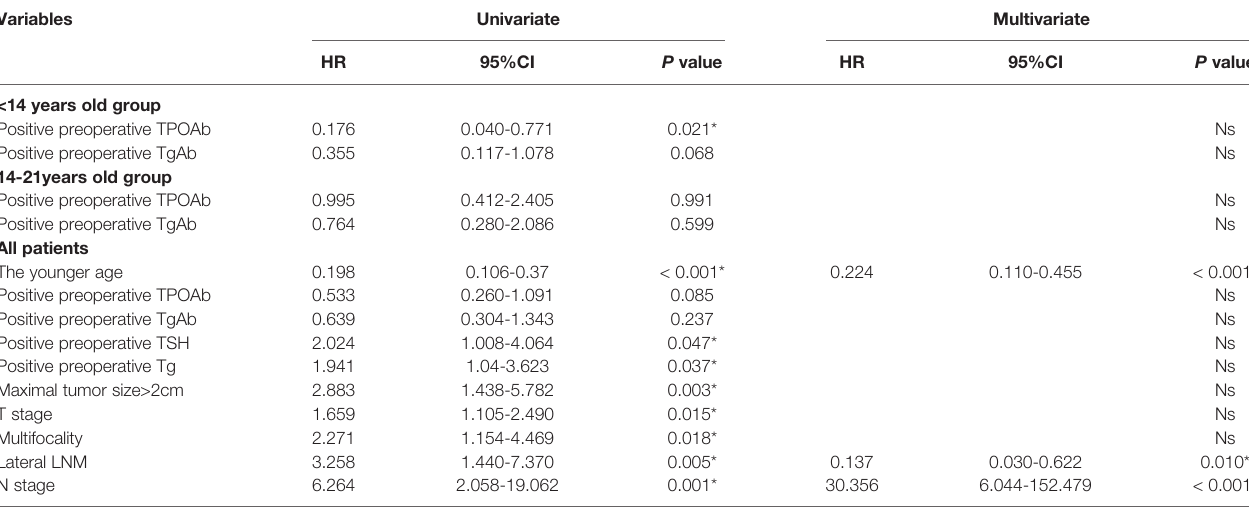
TABLE 4 | Cox proportional hazard regression analysis for variables associated with PTC recurrence at different